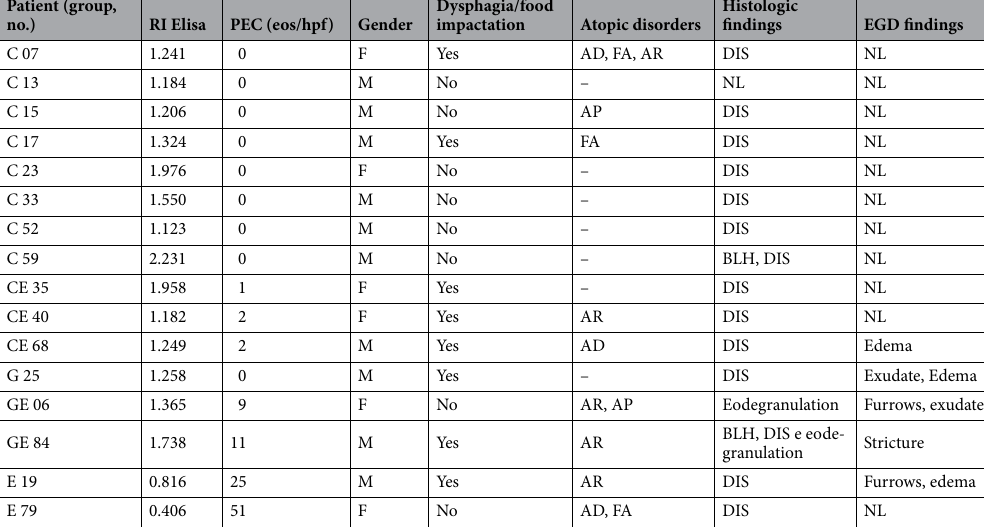
(Fig. 4B). A positive correlation was observed between the Reactivity Index (RI) and Peak Eosinophil Count/ hpf (Fig. 4C, r = 0.2801, p < 0.0063), with a greater association between Reactivity Index (RI) and Peak Eosino-